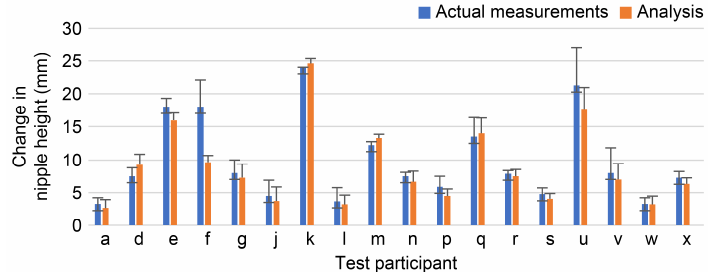
Figure 6. Results of difference between video analysis and actual measurement.